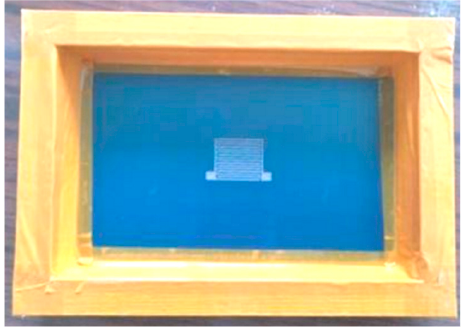
Figure 4. Interdigitated electrode printing screen.